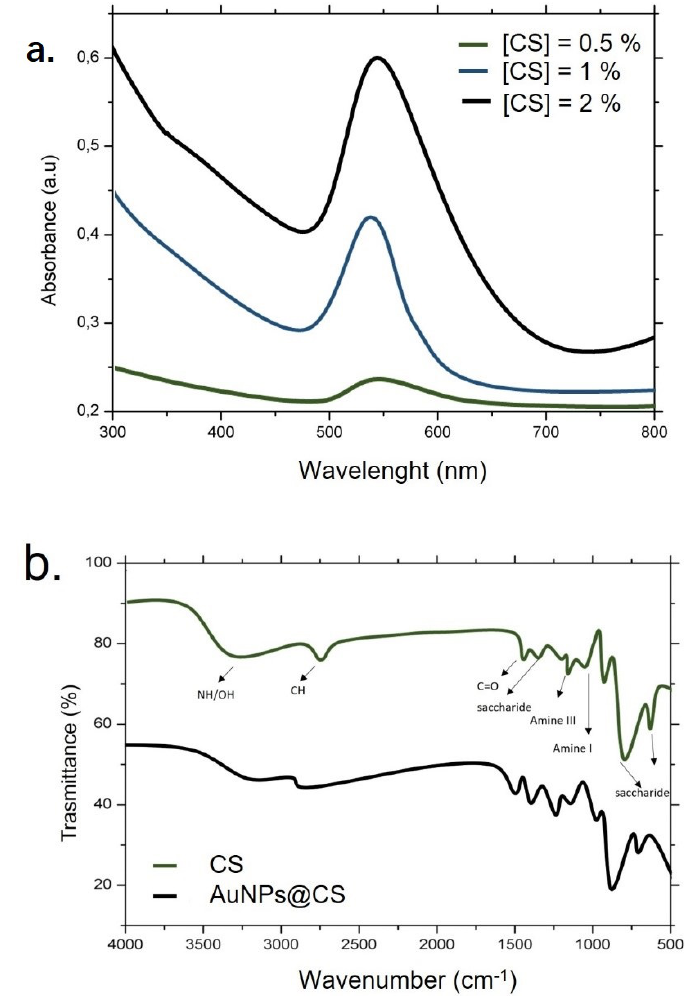
Figure 4. ( a ) UV–vis spectra of AuNPs@CS using different chitosan concentration (0.5%, 1%, and 2%) ( b ). FTIR spectra of pure medium chitosan and AuNPs@CS.